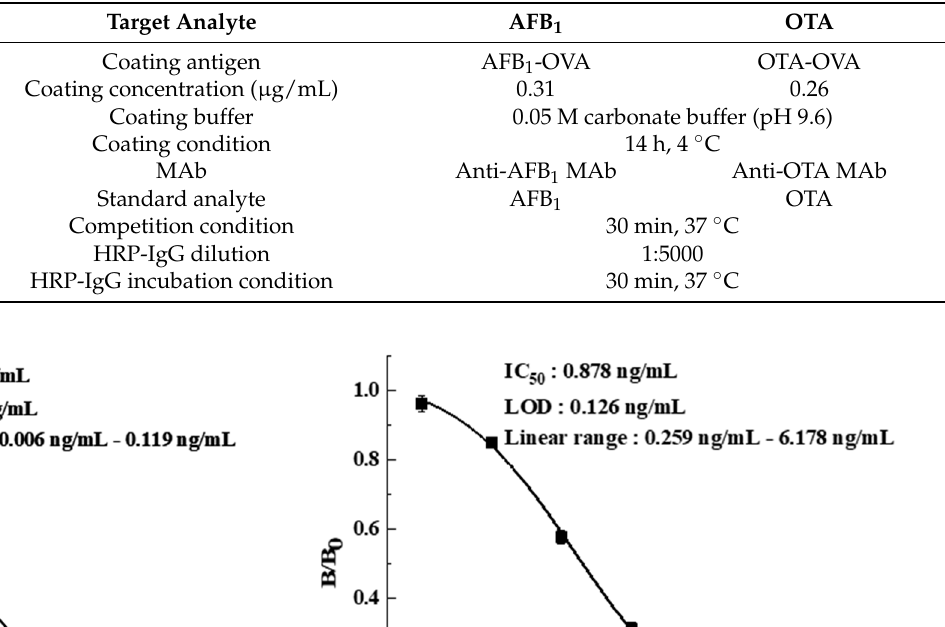
Table 1. Parameters for ic-ELISA.